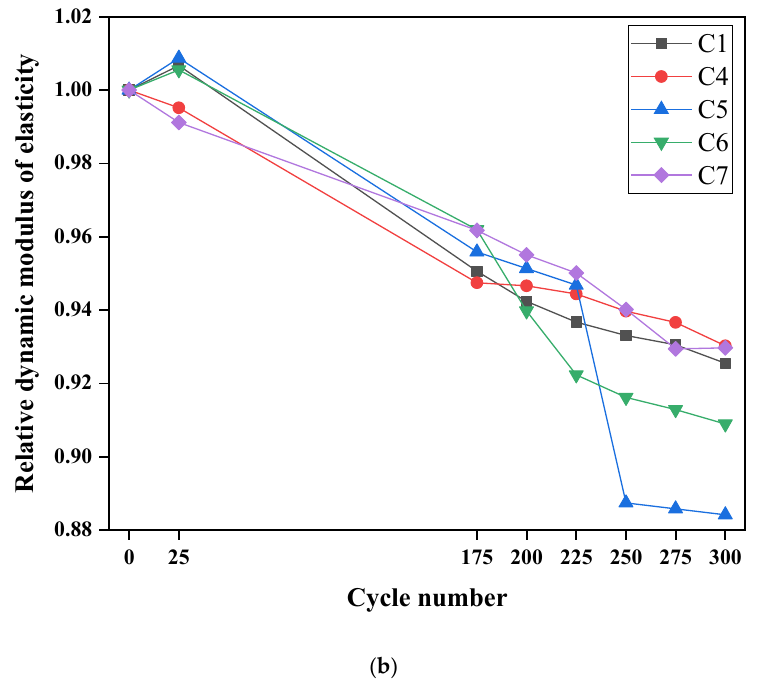
Figure 10. Results of mass loss ( a ) and relative dynamic modulus of elasticity ( b ) after freeze-thawing tests.